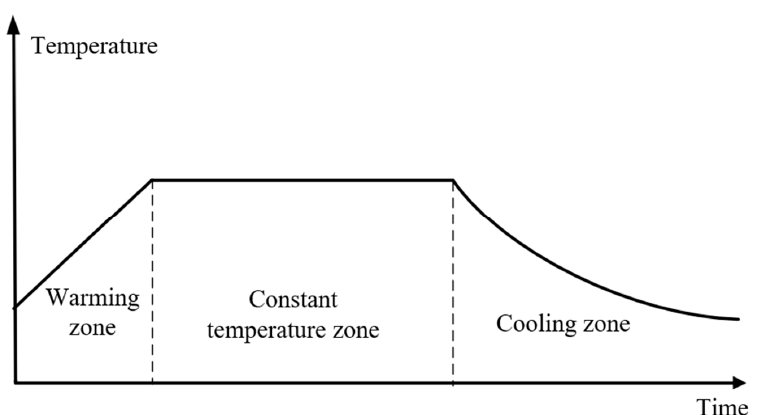
Figure 3. Temperature change curve.